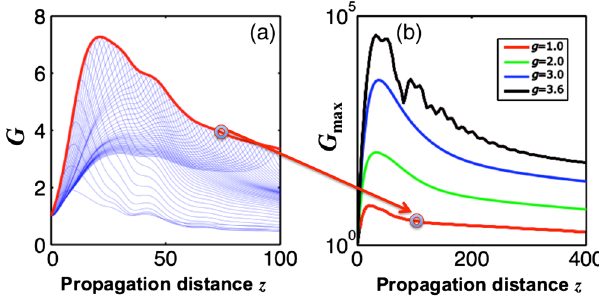
FIG. 4. (a) Power amplification for g ¼ 1 versus the propaga- tion distance, for many different optimal initial conditions (thin blue curves). (b) Transient power growth in logarithmic scale as a function of the propagation distance z for different values of the gain and loss amplitude g . The system is the same as the one considered in Fig. 1. Each G curve is the envelope of many max different G curves.